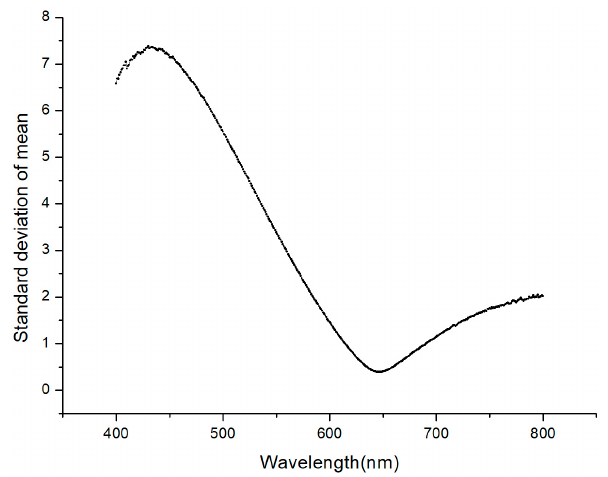
Figure 4. The standard deviation curve of the reflectivity change of all cells at different wavelengths.